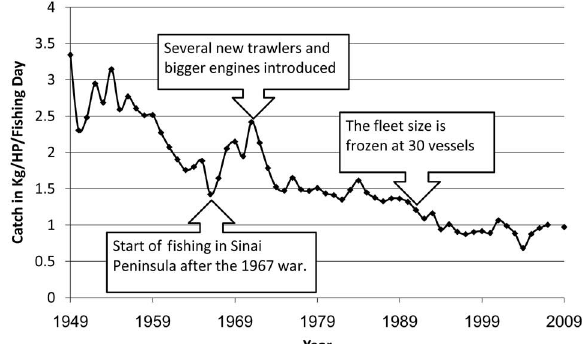
Fig . 2. – Declines in CPUE (catch per unit effort) of Israeli trawl- ers based on data collected by the Department of Fisheries in the Ministry of Agriculture since 1948. The effort unit used was engine horsepower per day at sea, as used by Garcia and Demetropoulos